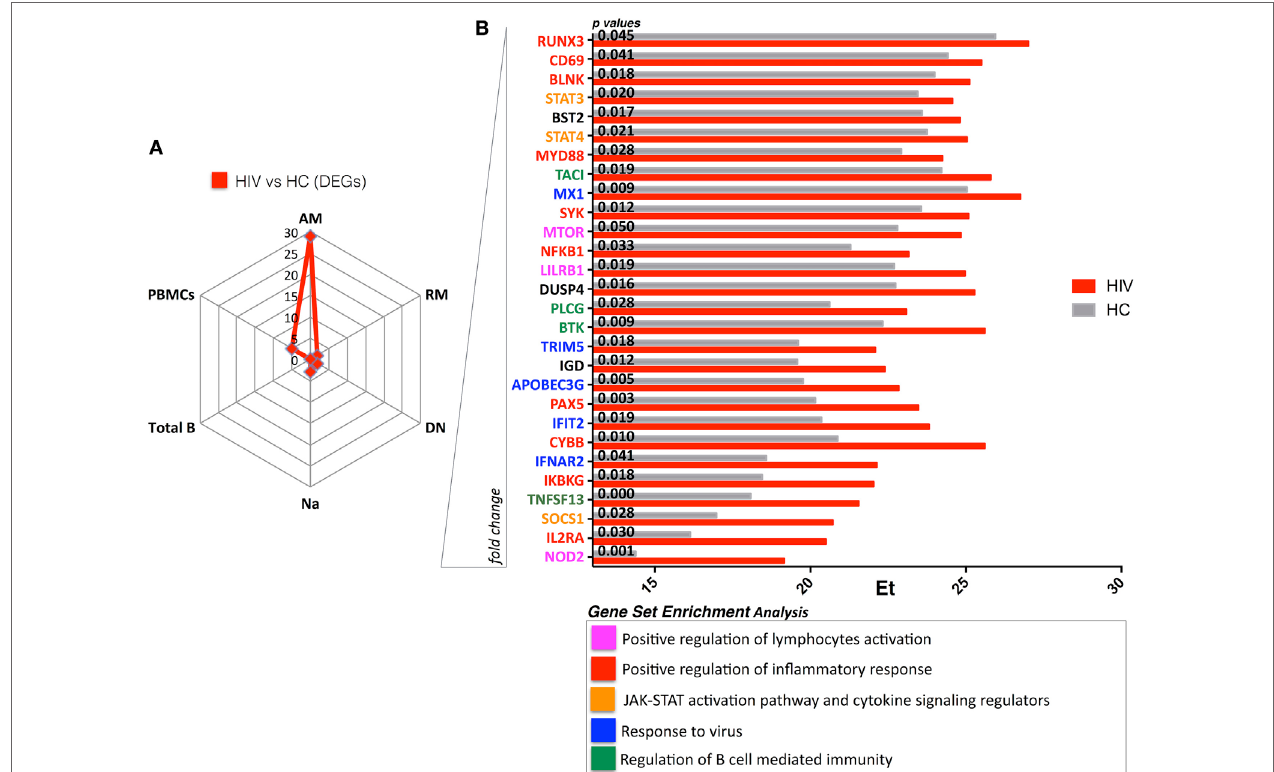
FigUre 2 | HIV present higher expression of genes involved in immuneactivation and inflammation in activated memory (AM) B cells despite effective antiretroviral therapy (ART) and long-term viral suppression. Graphs in panels (a,B) show comparisons in gene expression between healthy control (HC) and HIV. (a) Spider plot shows number of differentially expressed genes (DEGs) for all the subsets and total peripheral blood mononuclear cells (PBMCs). Box plots in panel (B) show gene expression averages from DEGS resulting in AM between HIV and HC (gene ranking defined by fold change). In this figure, p -values resulting from ANOVA analysis are shown. Color-labeled genes are defined according gene set enrichment analysis (performed by genemania.org) as described in the